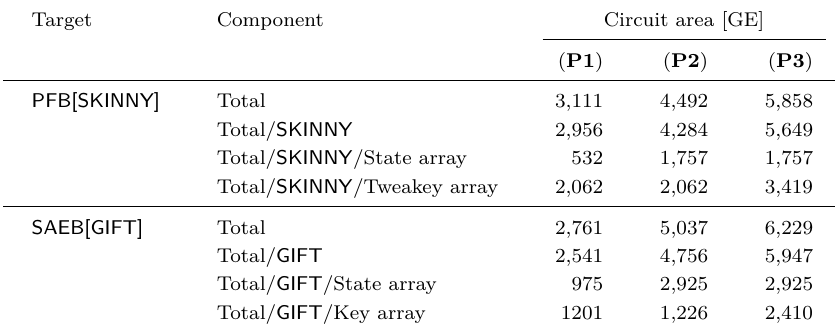
Table 3: Breakdown of the post-synthesis circuit area of PFB[SKINNY] and SAEB[GIFT] .